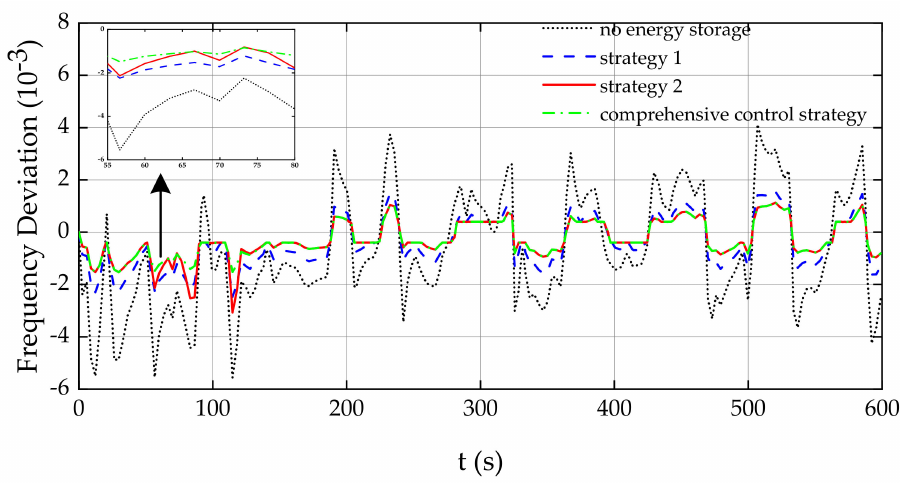
Figure 12. Frequency deviation curve under 10 min continuous load disturbance.